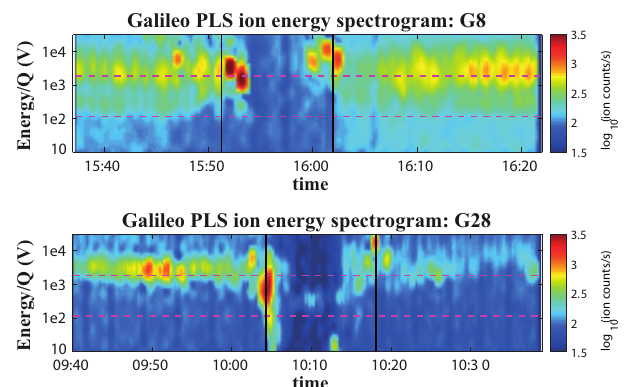
Fig. 9. Ion energy spectrograms measured by the Galileo PLS dur- ing the G8 (top) and G28 (bottom) flybys. The colour-coded ion counting rate represents the maximum response at a given E/Q dur- ing one spacecraft spin period. In each plot, two horizontal dashed lines mark the mean energies for two ion masses (top line for 16AMU and bottom for 1AMU) determined for a given velocity of the ambient Jovian flow (150kms − 1 ). The PLS data were ob- tained from the PPI node of the Planetary Data